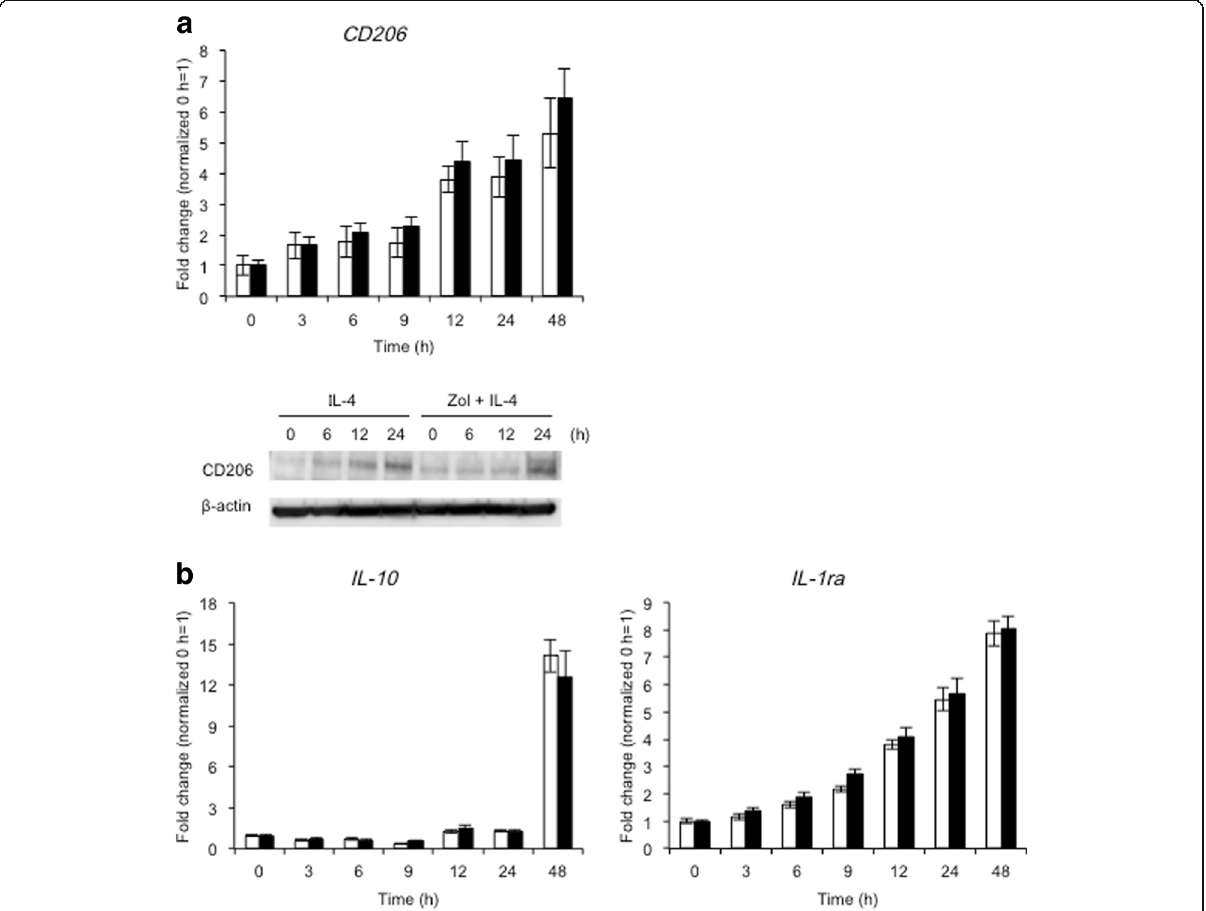
Fig. 4 Effects of zoledronic acid on mRNA and protein expression of M2 macrophage markers in IL-4-treated THP-1 cells. THP-1 cells were treated overnight with 100 ng/ml PMA, washed with PBS, and incubated with or without Zol for 24 h. THP-1 cells were then treated with 50 ng/ml IL-4. mRNA expression was detected by the real-time RT-PCR. Protein expression was detected by western blotting. Open bars represent IL-4-treated THP-1 cells; filled bars represent Zol and IL-4-treated THP-1 cells. a Zol did not affect the mRNA and protein expression of CD206 in IL-4-treated THP-1 cells. b Zol did not affect the mRNA expression of IL-10 and IL-1ra in IL-4-treated THP-1